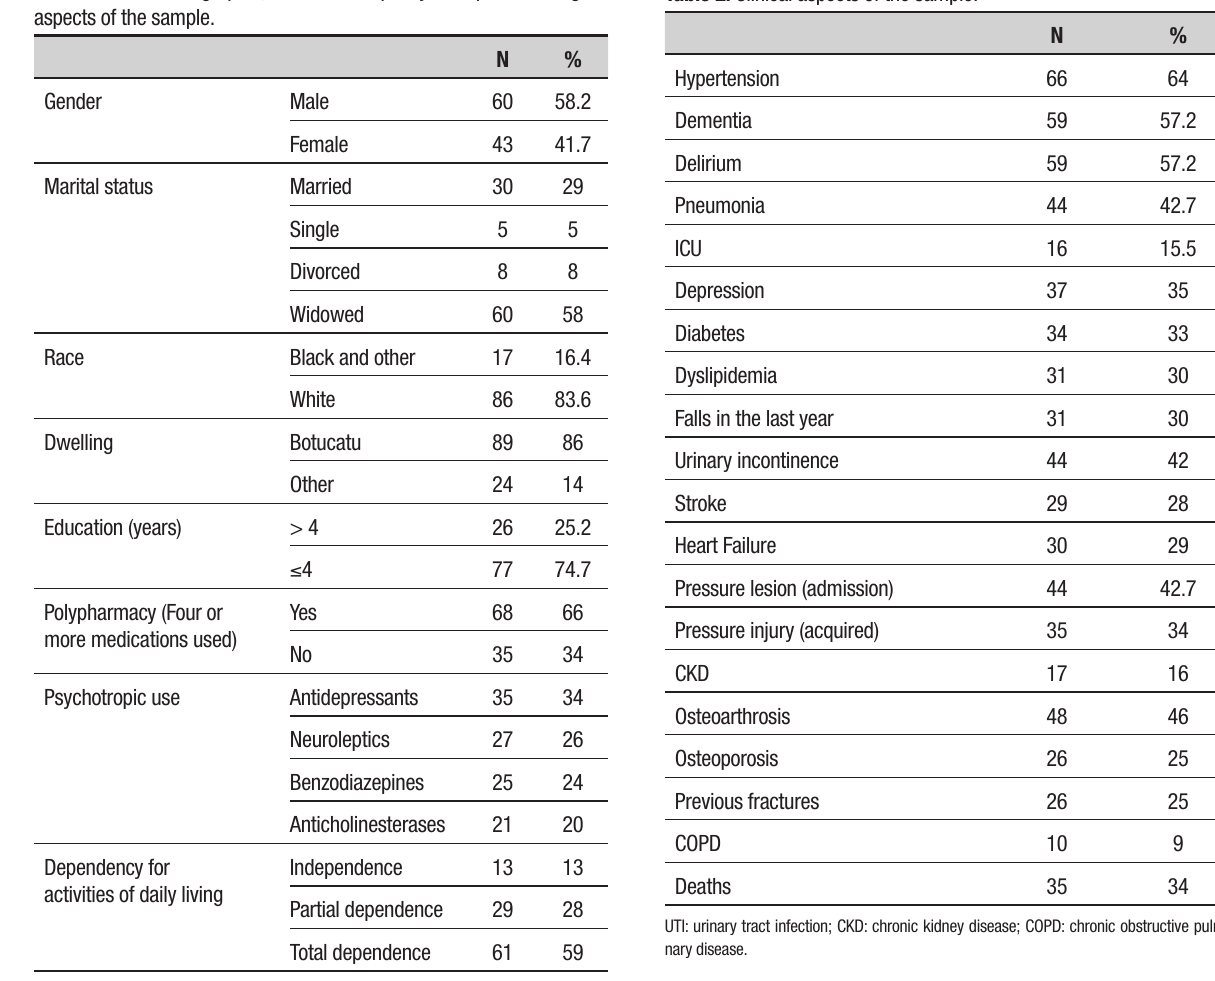
Table 2. Clinical aspects of the